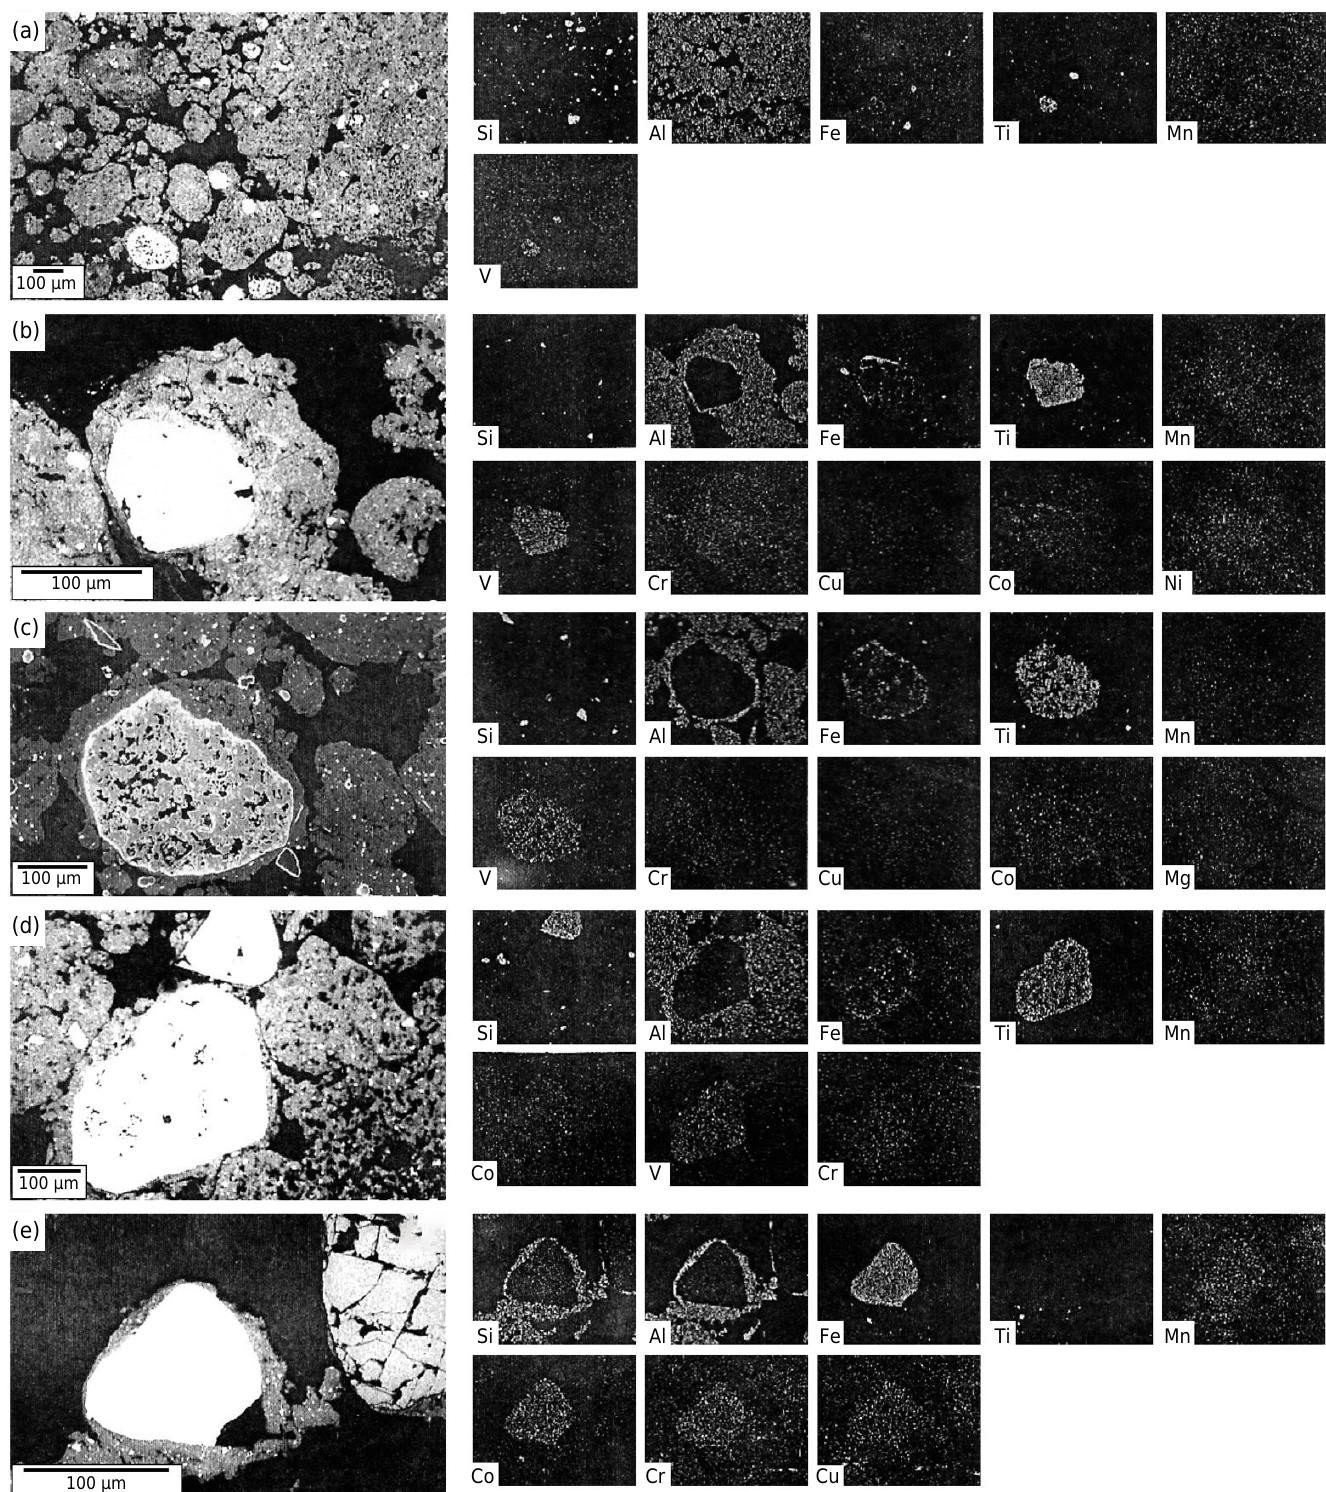
Figure 6. Scanning electron microscope photomicrographs and EDS microchemical maps of the Bw 2 horizon in the P 3 - Geric Acric Rhodic Ferralsol (Clayic, Dystric); Serra do Salitre topolithosequence. Well-developed oxic microstructure (a), a higher content of iron at the edges of the leucoxene grains (b, c, and d), and ferruginous concretions